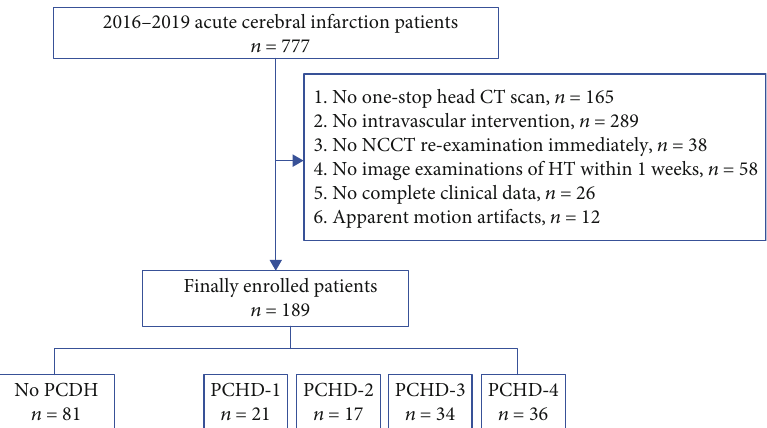
Figure 1: The fl owchart of participant